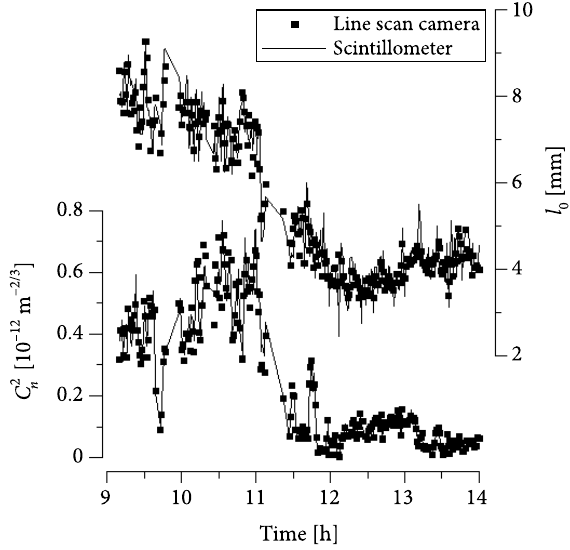
Fig. 3. Image processing versus scintillometry (Flach 2001)